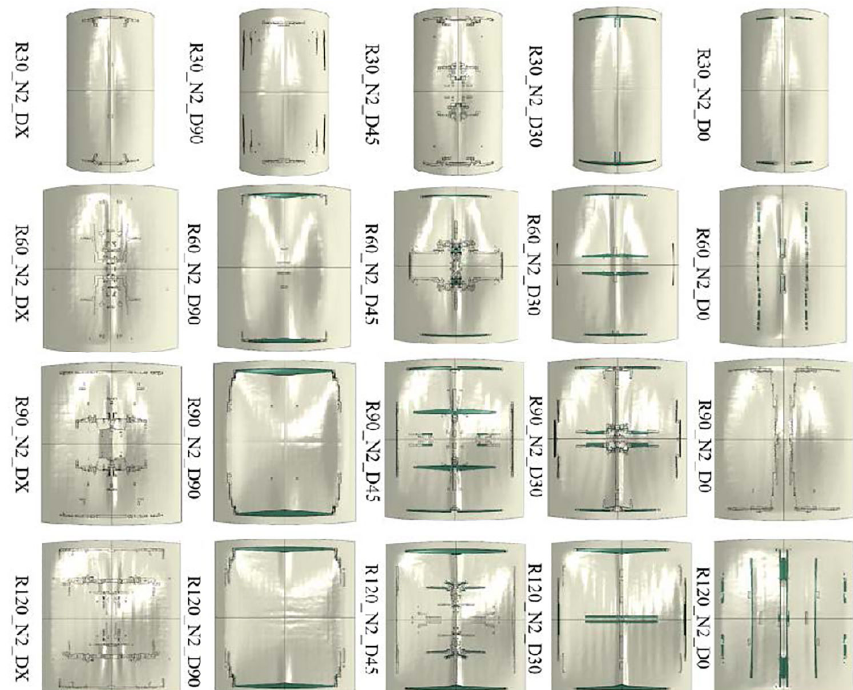
Figure 21. Comparison of deformation modes at the maximum center deformation time of double- layer CARALL with different fiber arrangements.